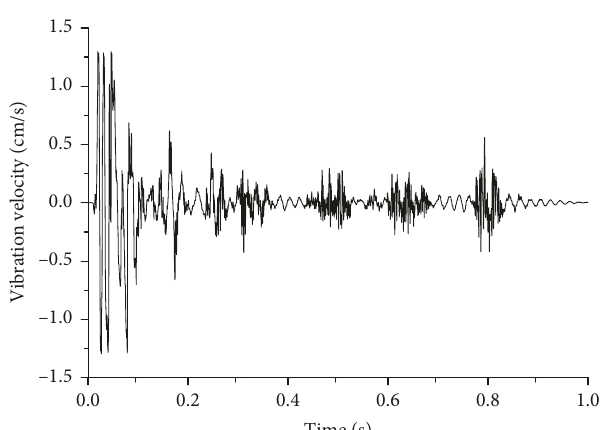
Figure 5: Vertical vibration waveform of the upper step at T-1.